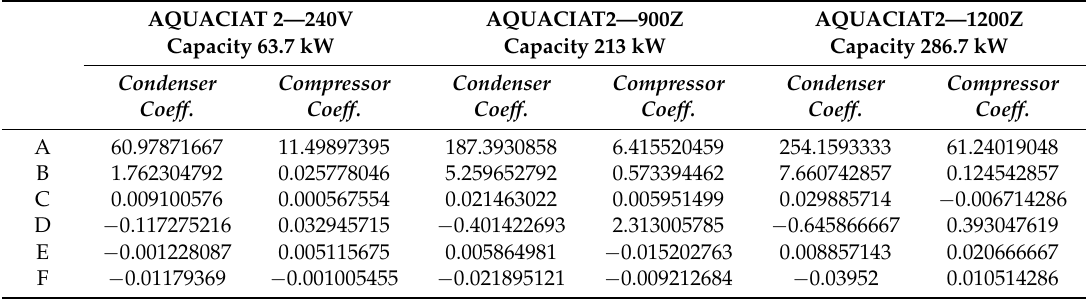
Table 1. Example fitted coefficients for heat pump models